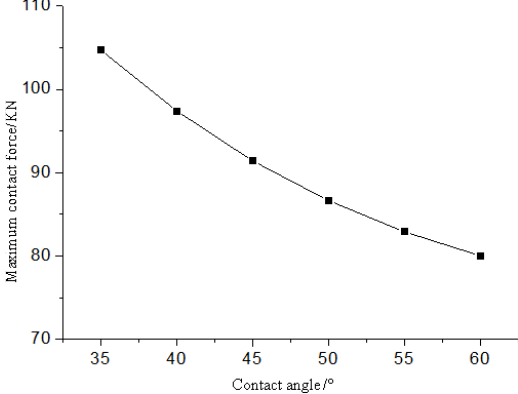
Figure 13: Effects of initial contact angle on the maximum contact force